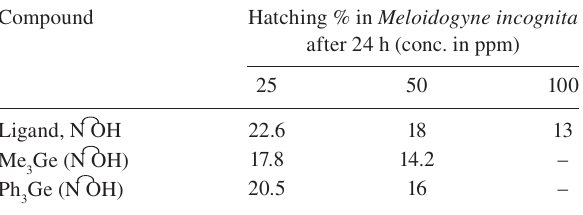
Table 4 Hatching % in Meloidogyne incognita of the ligands and their organogermanium